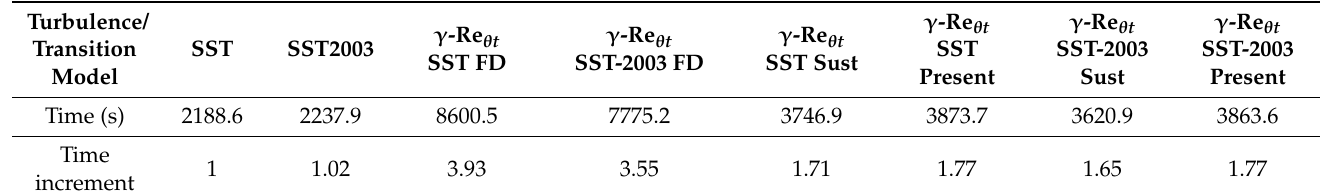
Table 1. Time consumption for different turbulence/transition models (FD means free decay).